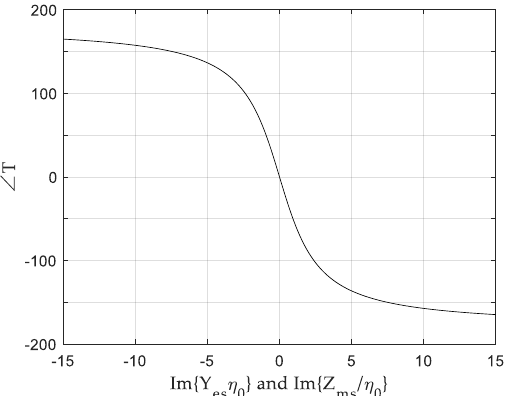
Figure 1. Transmission phases versus the imaginary part of the normalized surface electric admittance I m {Y es η 0 } and the normalized surface magnetic impedance Im{Z ms / η 0 }.